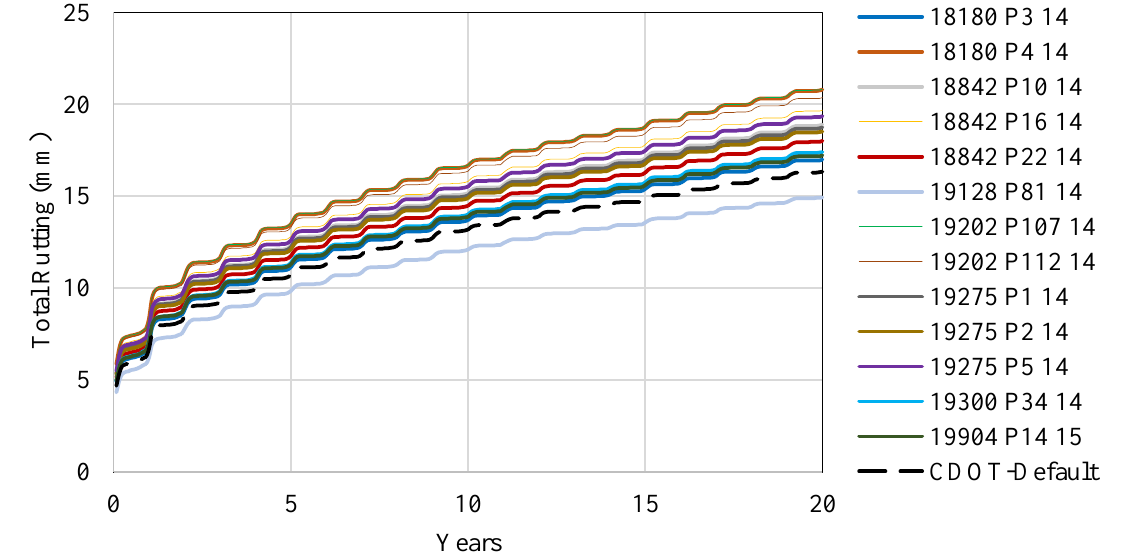
Figure 3. Total rutting due to AADTT = 7000 by SX (100) PG 64-22 mix. Rutting in the Asphalt Layer only: Figure 4 shows the rutting in the asphalt layer of the trial pavement with the service life of the pavement for AADTT = 7000. It shows that the prediction of rutting in the asphalt layer by the CDOT-default mix (except for 19128 P81 14) data is the lowest. This means that the CDOT-default dynamic modulus data for the PG 62-22 binder predicts lower rutting in the asphalt layer compared to that of the actual tested dynamic modulus (except for 19128 P81 14). Comparing contractor to contractor, the prediction varies a lot. For example, if the threshold total value is 8 mm (0.32 in.), then the prediction reaches the threshold from two to seven years. The statistical analysis shows that several mixes are within the 95% CI boundaries.